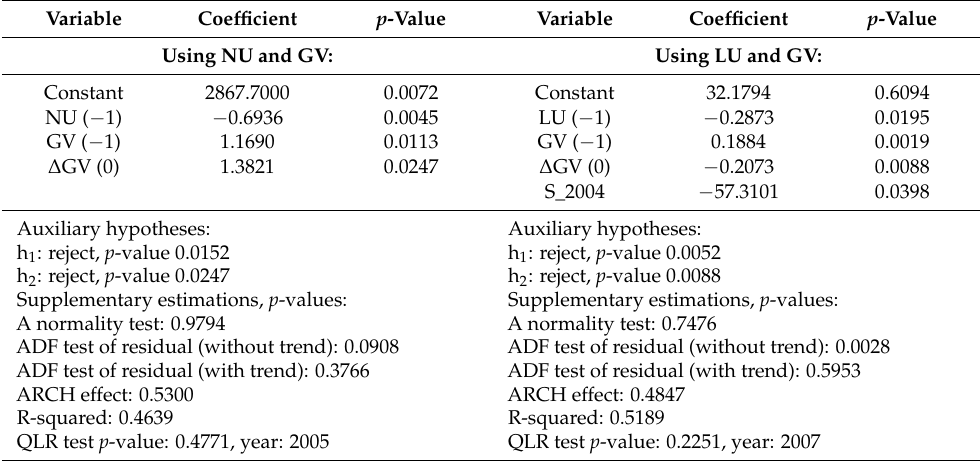
Table A3. ARDL estimations for Latvia after eliminating insignificant variables.